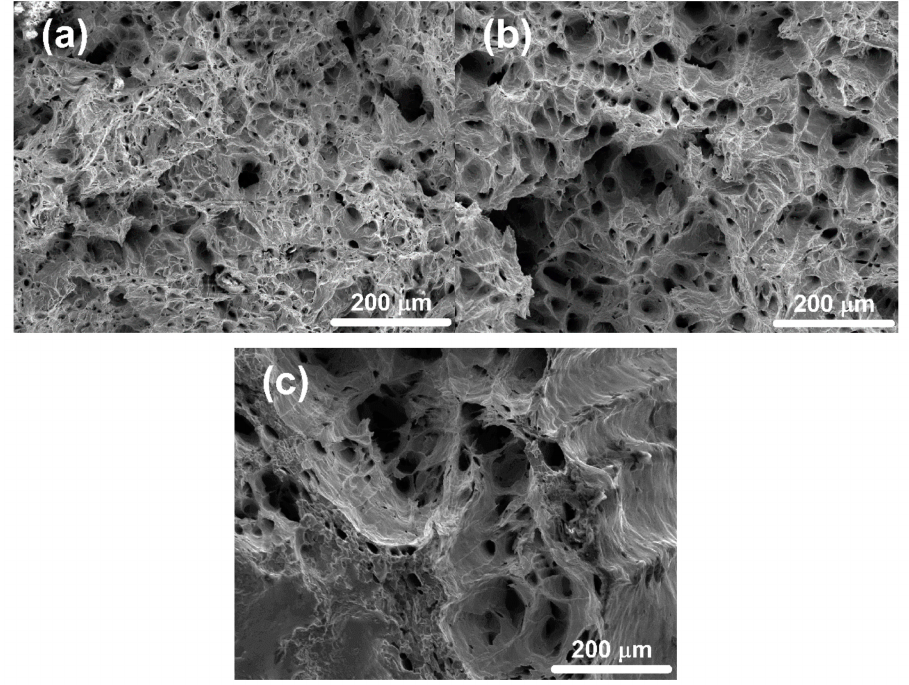
Figure 8. Microstructure of the tensile samples’ fractured surface after deformation at ( a ) 1100, ( b ) 1150 and ( c ) 1200 ◦